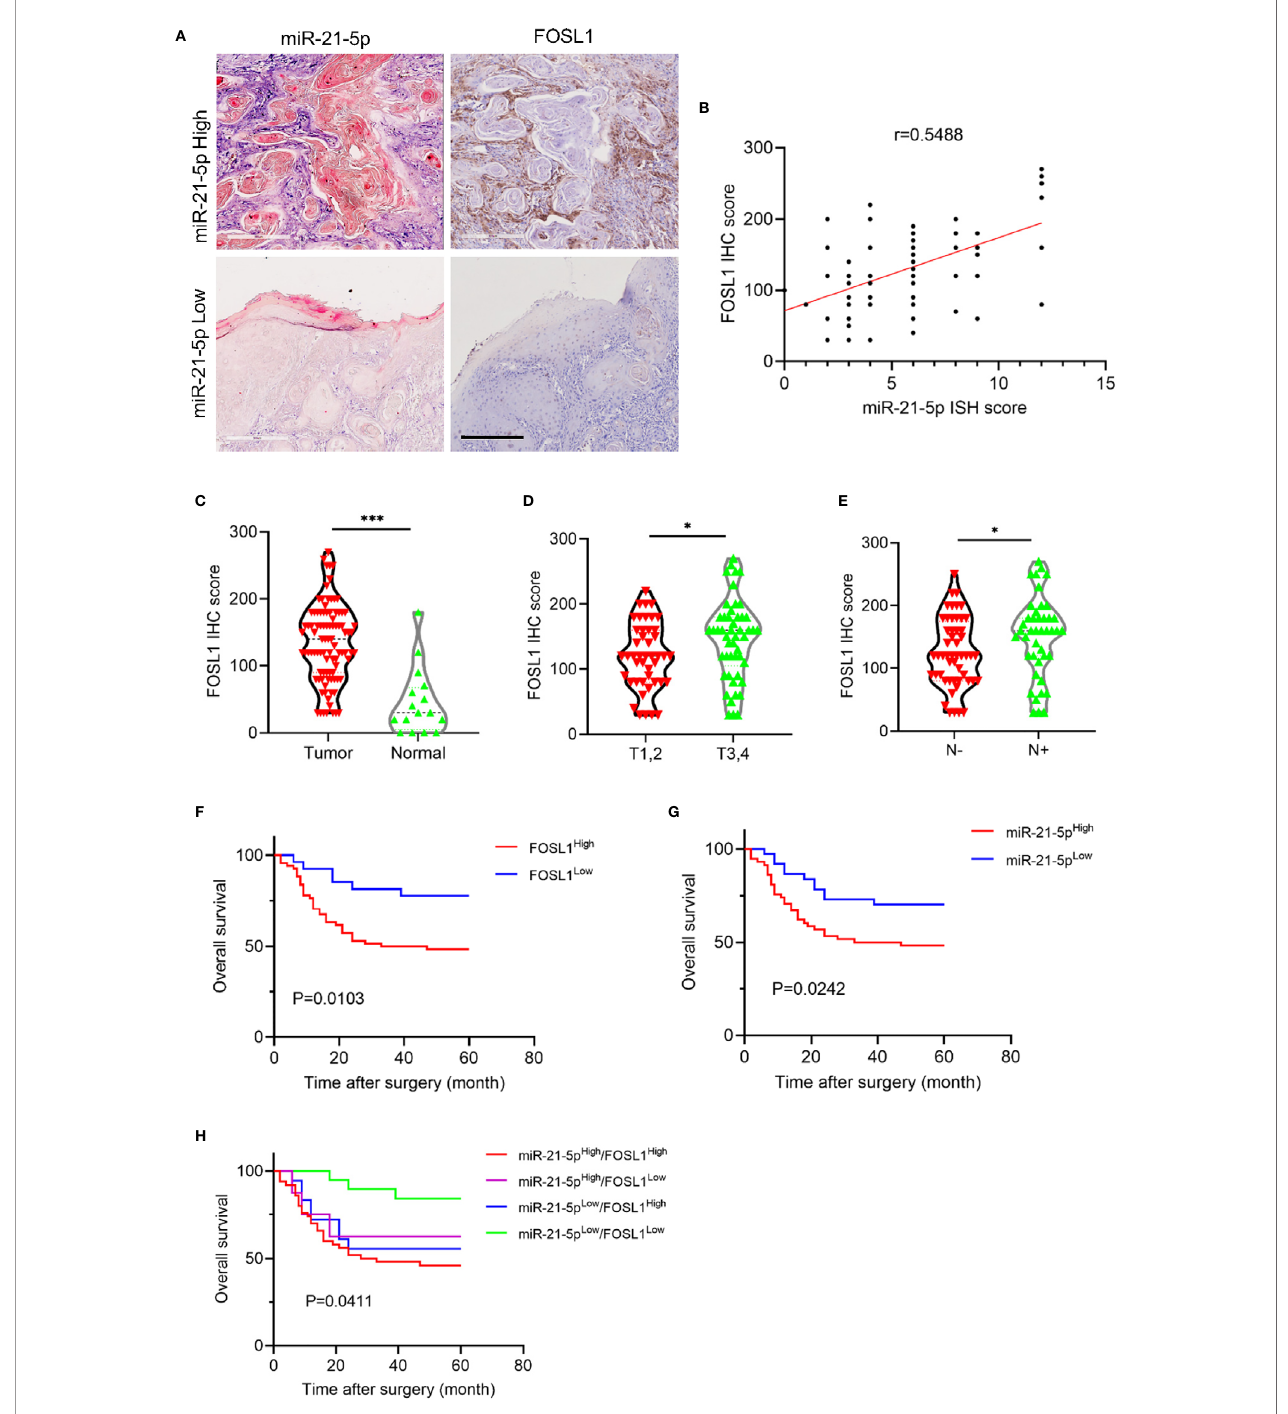
FIGURE 4 | miR-21-5p expression was positively correlated with FOSL1 in HNSCC. (A) The representative images of miR-21-5p ISH staining and FOSL1 IHC staining. Scale bar, 300 m m (B) FOSL1 expression was positively correlated with miR-21-5p expression. (C) The expression of FOSL1 was increased in HNSCC as comparted to the normal tissue. ***P < 0.001 by Student ’ s t-test (D) The expression of FOSL1 was increased in T3,4 stage HNSCC patient as comparted to those with T1,2 stage. *P < 0.05 by Student ’ s t-test (E) The expression of FOSL1 was increased in HNSCC patient with lymph node metastasis as comparted to those without lymph node metastasis. *P < 0.05 by Student ’ s t-test. (F) HNSCC patient with high FOSL1 expression levels indicated a poor overall survival. (G) HNSCC patient with high miR-21-5p expression levels indicated a poor overall survival. (H) HNSCC patient with high FOSL1 and miR-21-5p expression levels indicated a poorest overall